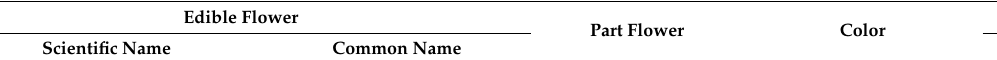
Table 6. Individual carotenoids values in edible